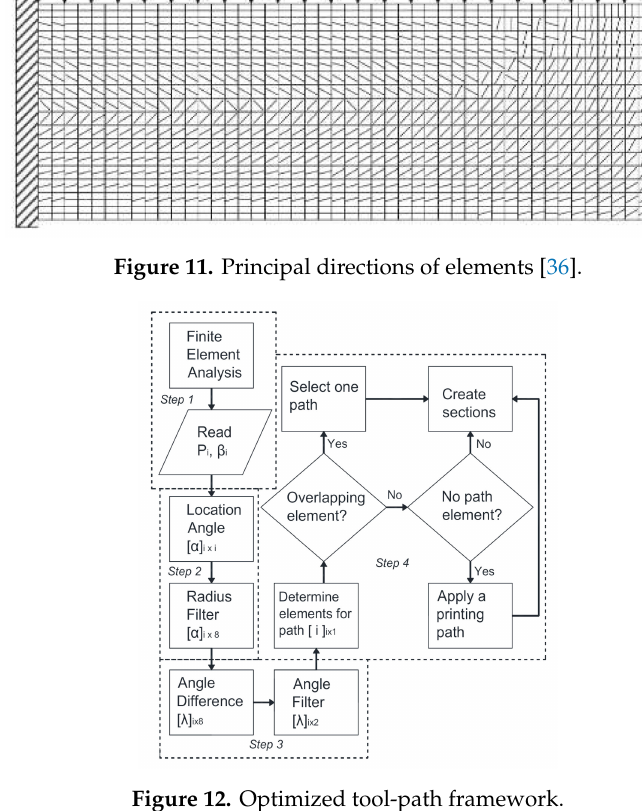
Figure 12. Optimized tool-path